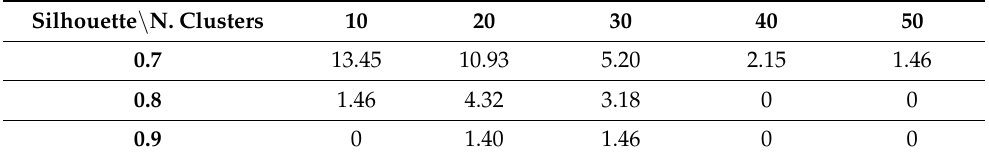
Table 53. Clustering performance in terms of silhouettes using the reduced dataset with PCA applied to normalized data.